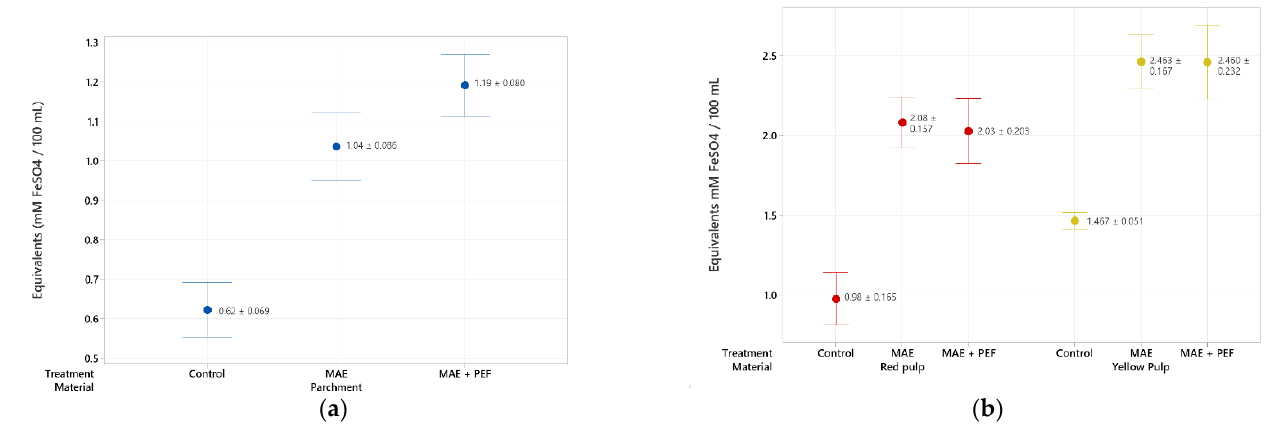
Figure 5. FRAP antioxidant assay of coffee agro-waste extracts. Values are represented as mean ± standard deviation ( n = 3). ( a ) Assay results for parchment waste. ( b ) Assay results for yellow and red pulp waste. MAE: Microwave assisted extraction; PEF: Pulsed Electric Field pretreatment.